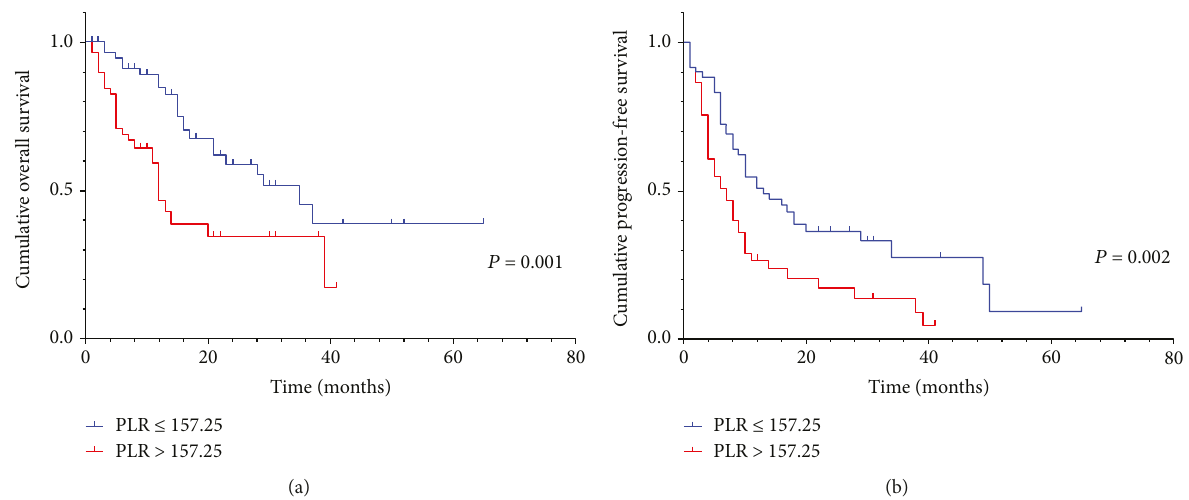
Figure 1: (a) Kaplan – Meier curve for OS of 119 CCA patients strati fi ed by PLR. (b) Kaplan – Meier curve for PFS of 119 CCA patients strati fi ed by PLR.